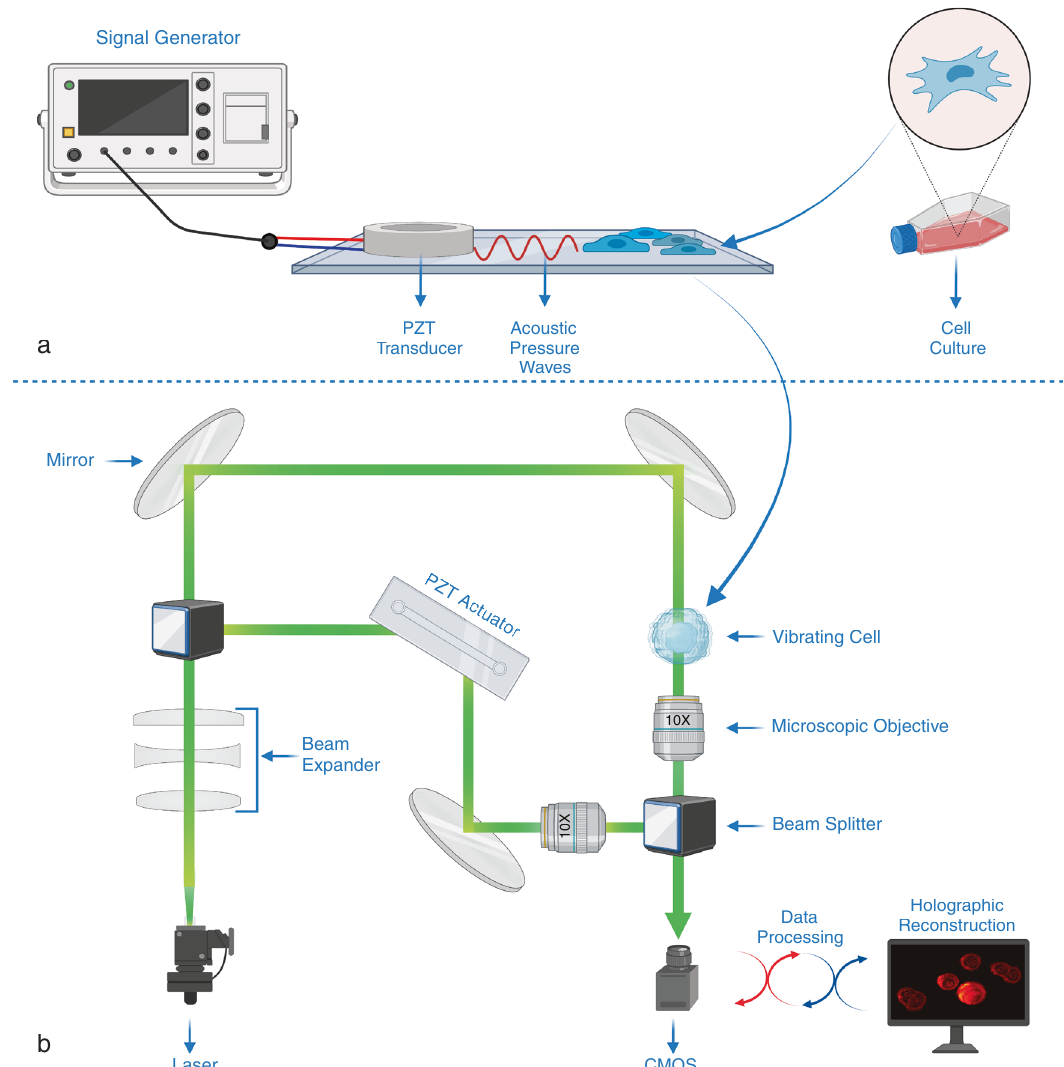
Fig. 1 | Acousto-holographic cell stiffness measurement. a Compression and deformation induced on a cell with a low intensity bulk acoustic wave is measured by an interferometric imaging system to obtain whole-cell stiffness distribution. A PDMS fl uidicchamberconsistingofaPZTtransducer,placedbetweenaPDMSlayer andaglasssubstrateitisbonded,isusedtostimulatethecellsinthechamberwith high-frequency acoustic signals. b Holographic imaging system is composed of a Mach-Zehnder interferometer whose output port is monitored with a CMOS detector (see “ Methods ” ). Light from a 527nm He-Ne laser is divided into two by a